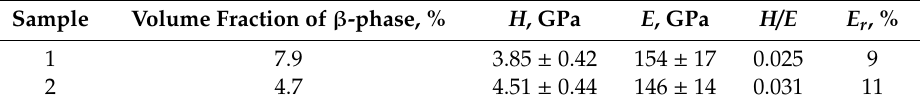
Table 1. Volume fraction of β -phase and mechanical properties of Ti-6Al-4V alloy samples.